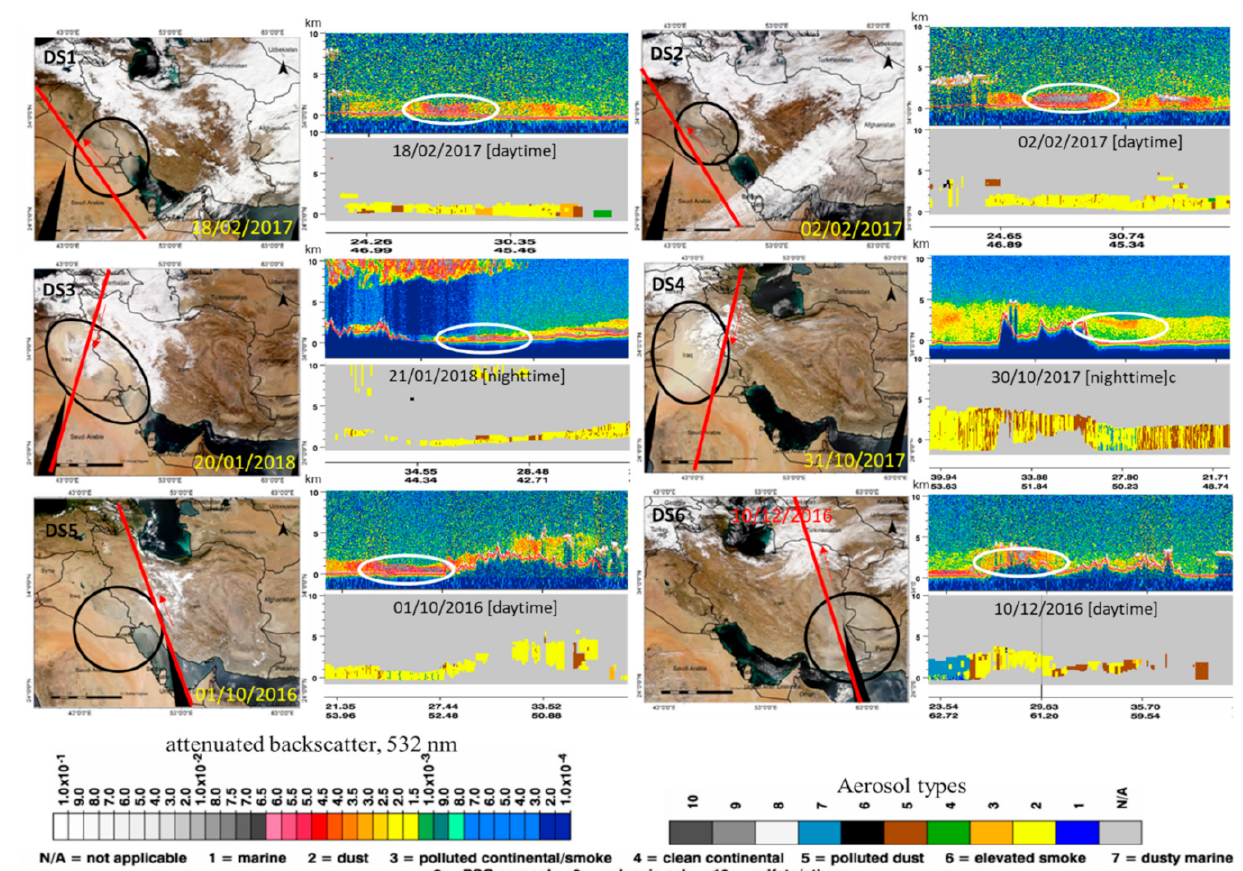
Figure 1. True color imagery from Aqua (DS5, DS6) and Terra (DS1–DS4) Moderate-Resolution Imaging Spectroradiometer (MODIS) and Cloud-Aerosol Lidar and Infrared Pathfinder Satellite Observation (CALIPSO) profiles of total attenuated backscatter at 532 nm (km − 1 sr − 1 ) and aerosol-type classification during the dust storm days over the Middle East. The CALIPSO orbit paths are shown by the red lines in MODIS imagery, with the arrows denoting the direction of the overpass, while the presence of the thick dust plumes is highlighted by the circle and oval shapes in the MODIS and CALIPSO